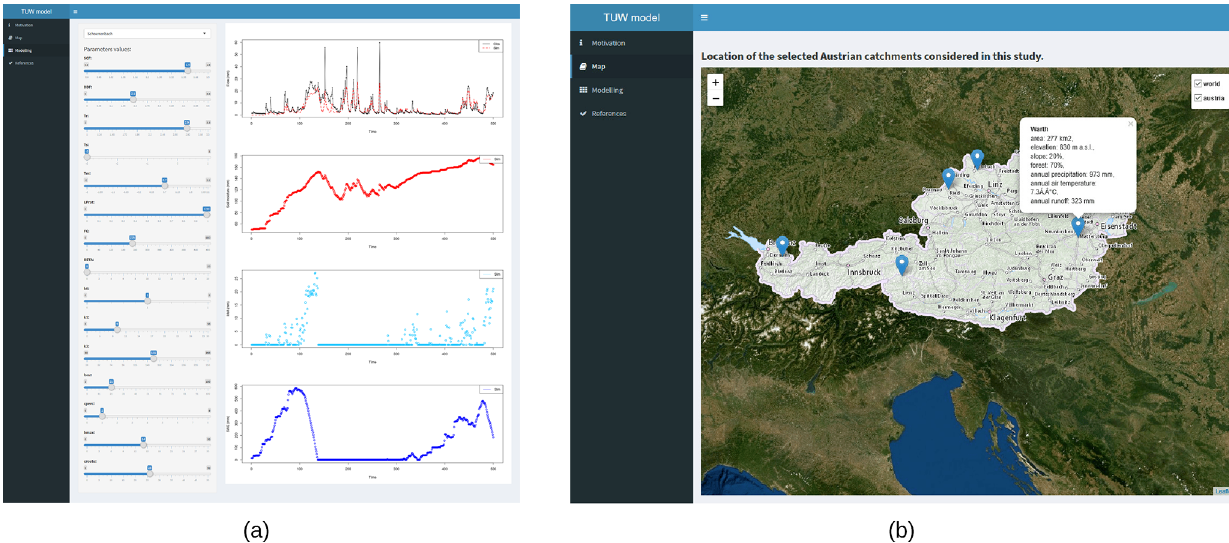
Figure B4. Graphical user interface of the TUWmodel package. (a) Tab where users can adjust the model parameters and see the impacts on (from top to bottom) the simulated hydrograph compared to the observed hydrograph, the simulated time series of soil moisture, the simulated time series of melt, and the simulated time series of snow water equivalent. (b) Tab where users can visualise the localisation of the five available catchment data sets on a map of